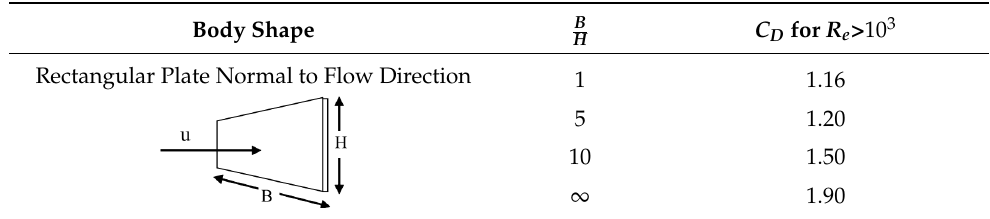
Table A8. Drag coefficients for the flow normal to the rectangular plate (reproduced from [48], with permission from DNV, 2021).